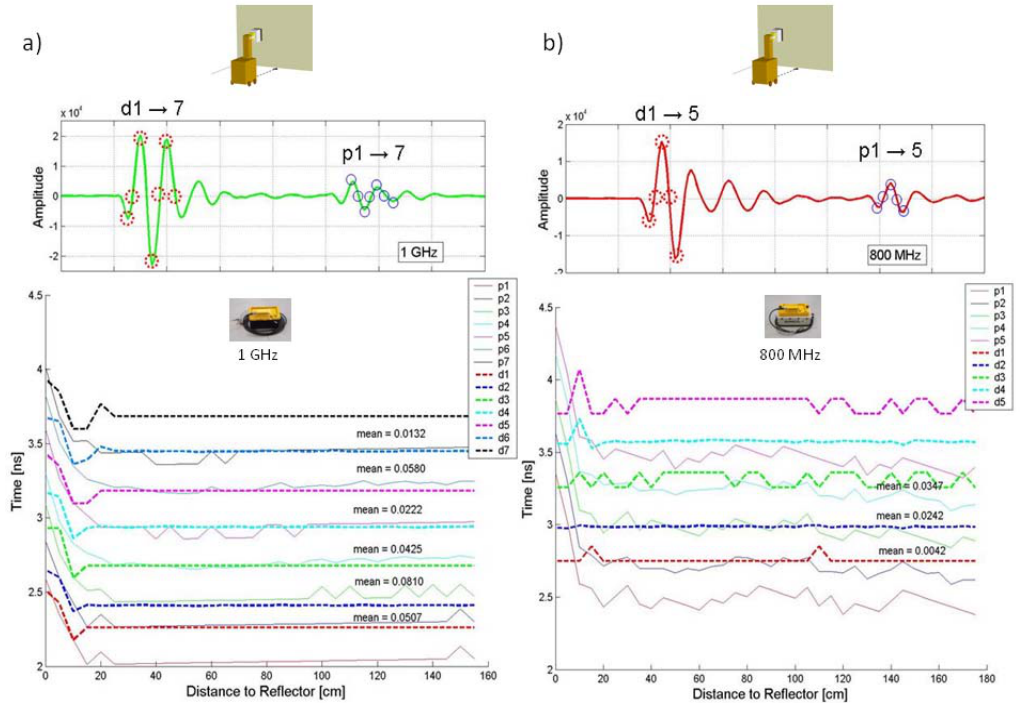
Figure 11. Time zero analysis from data obtained using the methodology shown in Figure 5(c). The figure displays the points taken as reference in each trace collected at different distances between the antenna and PEC. Each point represents a line shown in the lower part of the figure. The position of the reflected wavelet points are corrected according to the antenna-PEC distance at the time of the measurement. The average distance between closest lines is